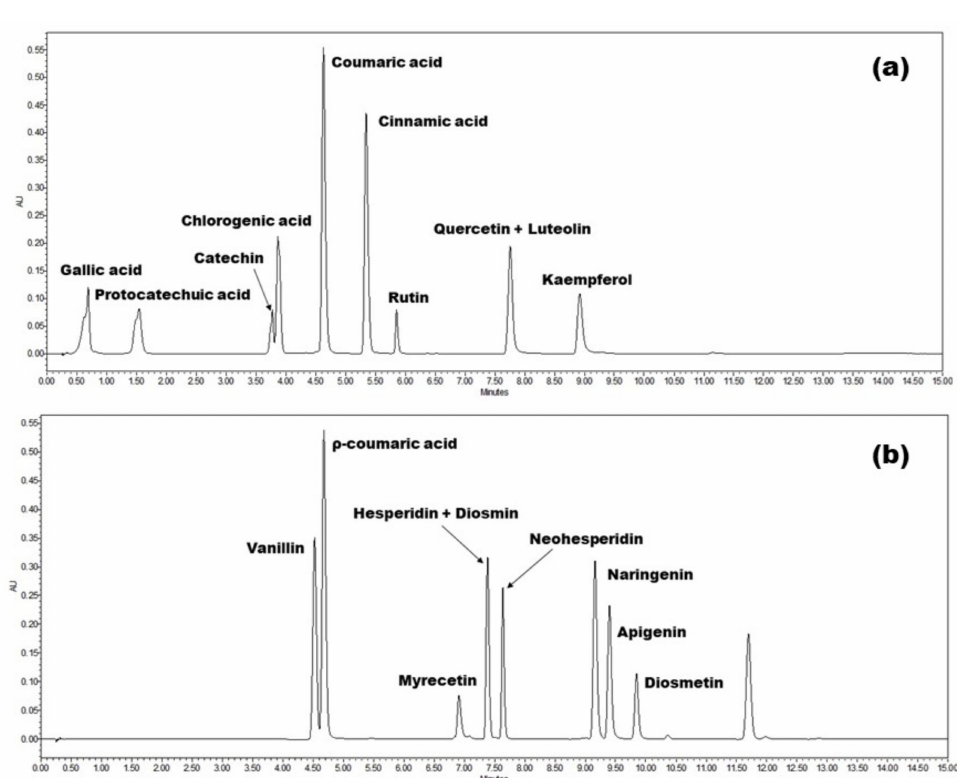
Figure A1. Chromatograms of standards at a concentration of 75 µ g mL − 1 : ( a ) Calibration curve made up of: gallic acid, protocatechuic acid, catechin, chlorogenic acid, coumaric acid, cinnamic acid, rutin, quercetin + luteolin and kaempferol. ( b ) Calibration curve developed for: vanillin, ρ -coumaric, myricetin, hesperidin + diosmin, neohesperidin, naringenin, apigenin and